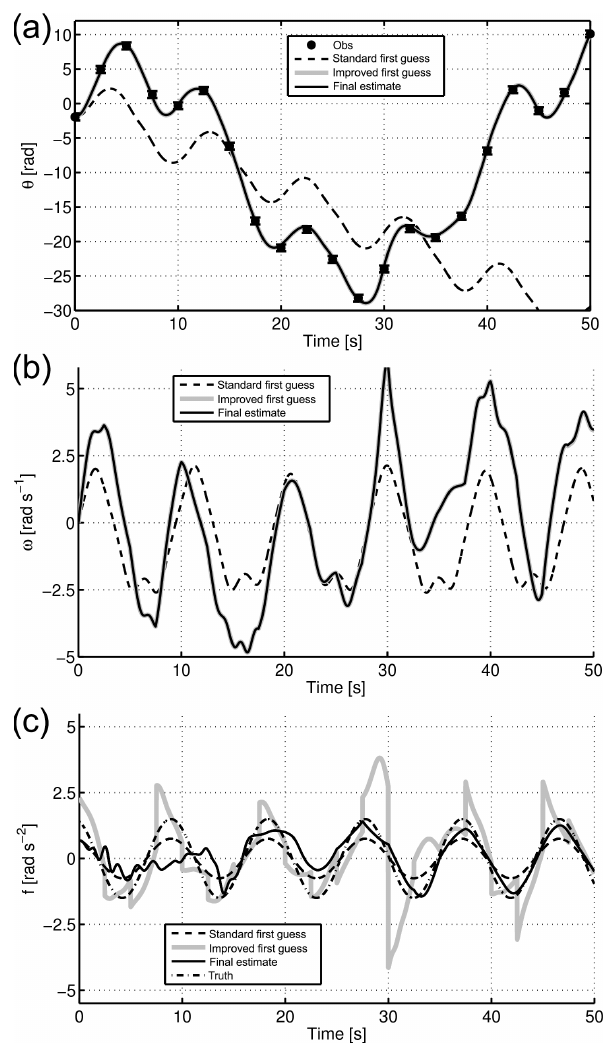
Figure 8. Control of the chaotic pendulum with an inaccurate first guess of the external forcing. (a) Observations are taken every 2.5s with standard error of 0.5rad (circles with 1 σ error bars). The tra- jectory of the pendulum angle ( θ(t) , a ), angular velocity ( ω(t) , b ), and the forcing ( f (t) , c ) are given for a standard first-guess (dashed line), the improved first-guess (gray line), and the final Lagrange multiplier-based estimate (black line). In the forcing panel, we also include the true forcing (dash-dot